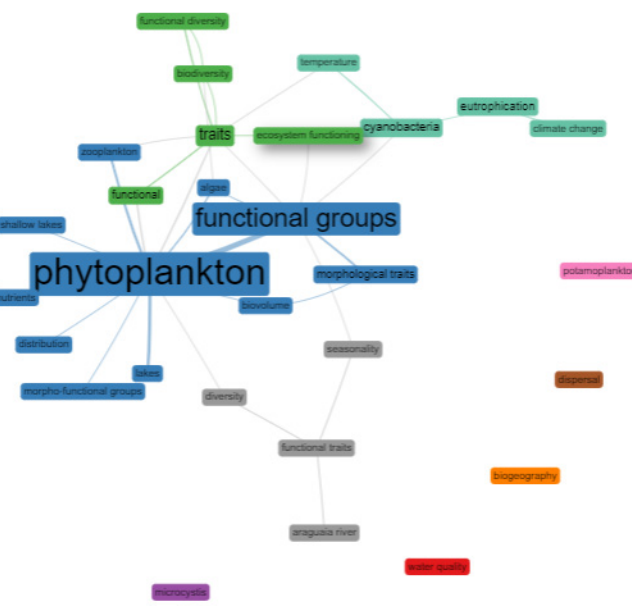
Figure 3. Network co-occurrence of the 30 more used keywords in papers published between 2010 and 2018, referring to Kruk et al. (2010). The size of the nodes represents the proportion of the frequency of occurrence. The lines represent the connection relationship between two keywords, and the thickness of the lines represents the strength of the